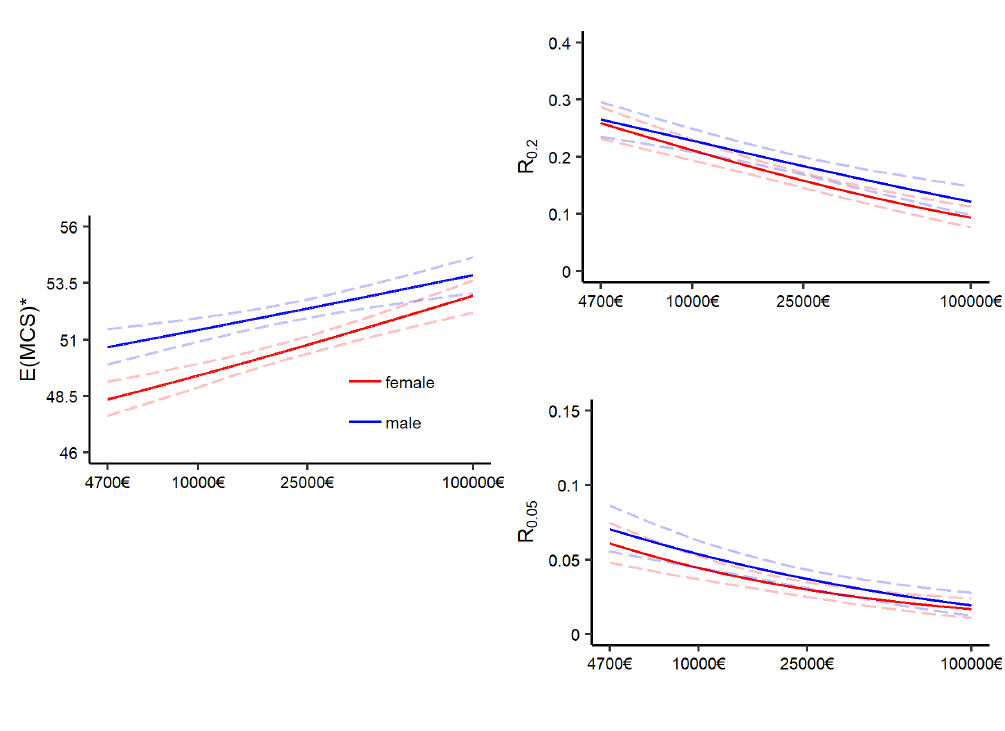
Figure A3. Effect of income on distribution measures for the BCPE-model: BCPE ( µ = (cid:88) , σ = (cid:88) , ν = (cid:88) , τ = − ). Left : Effect of income on the expectation; right : Effect of income on risk of falling below the lowest quintile and lowest vingtile.